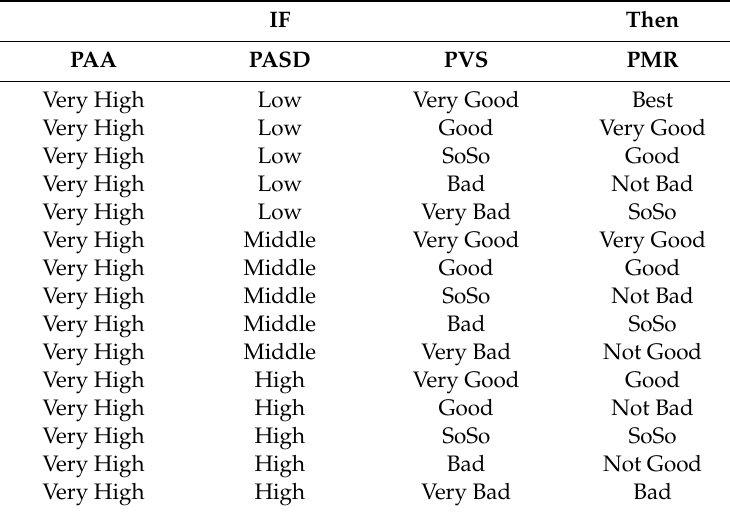
Table 4. Pronation motion’s rules of Stage 1.